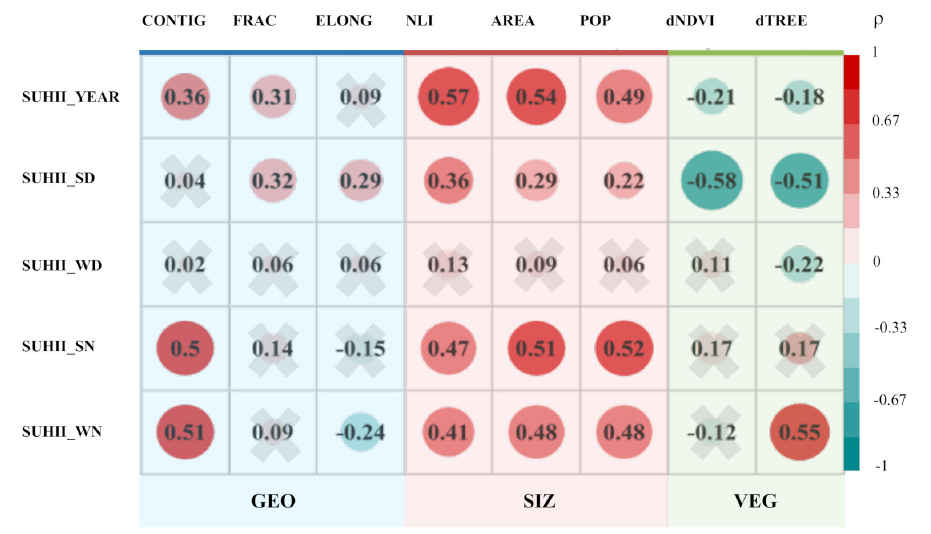
Figure 5. Correlation heat map of the UFIs with SUHIIs of the year (SUHII_YEAR), summer day (SUHII_SD), summer night (SUHII_SN), winter day (SUHII_WD), and winter night (SUHII_WN). The color and size of the dots represent the correlation coe ffi cient value, and a cross indicates a coe ffi cient below